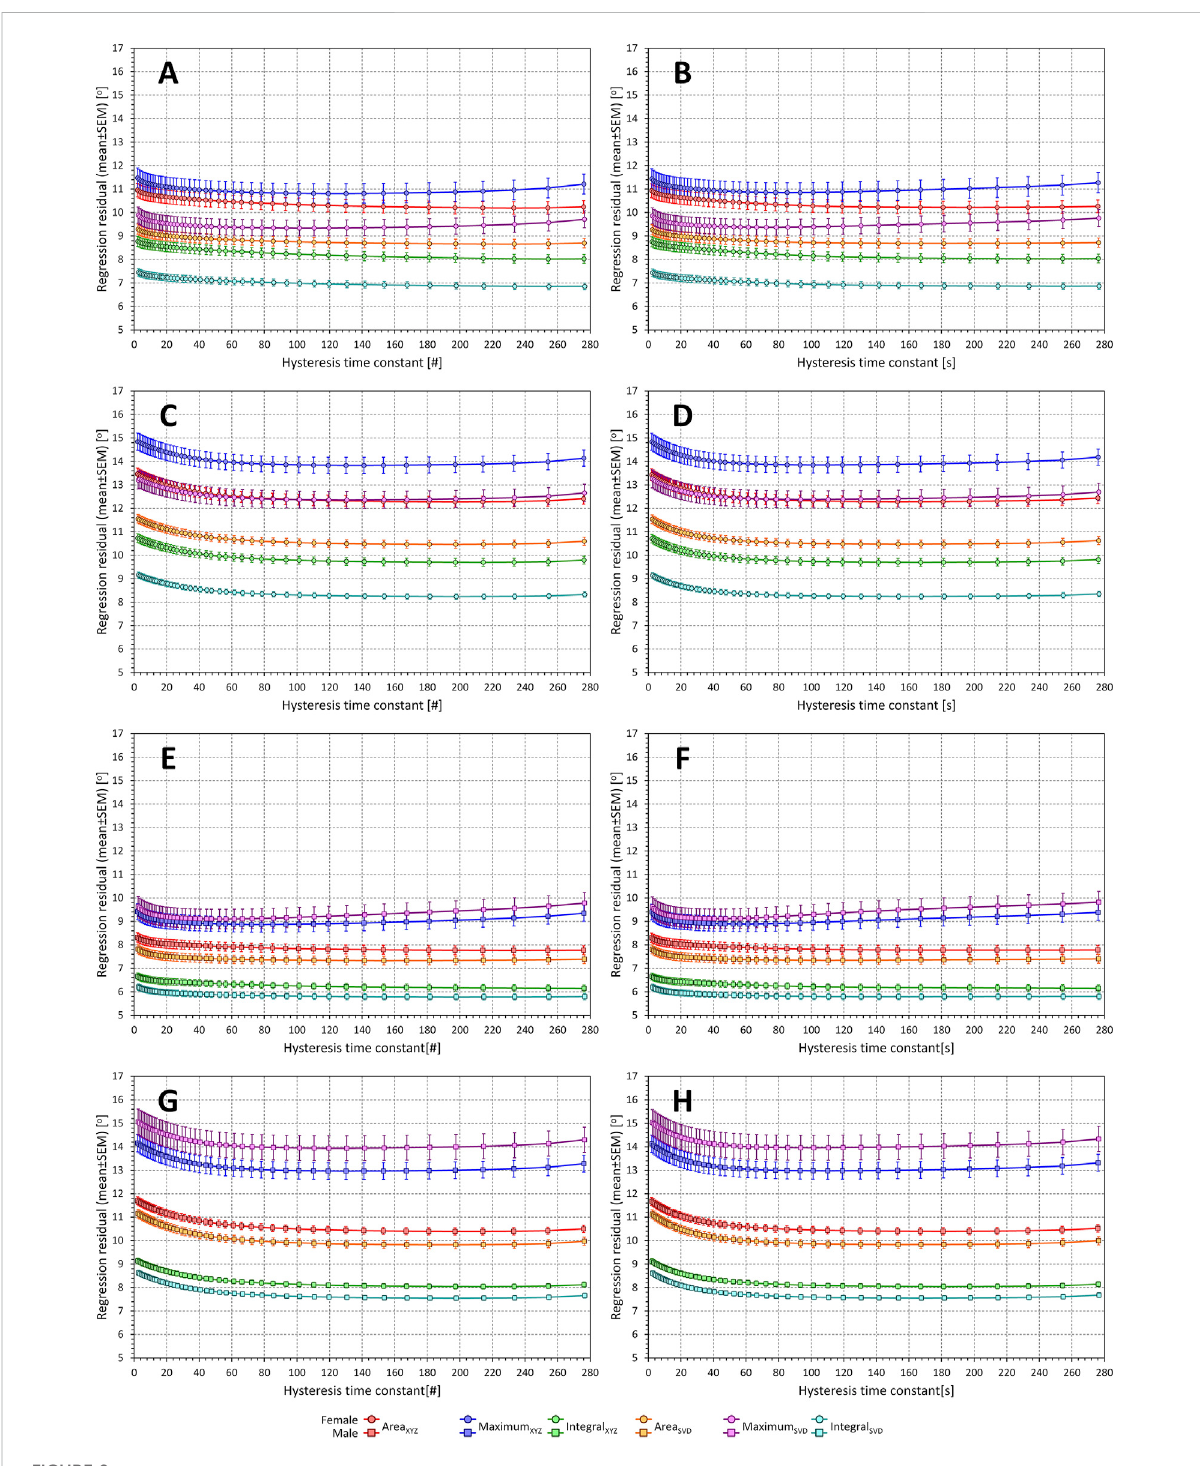
FIGURE 9 Regression residuals of QRS-T angle related to exponential decay of preceding heart rate. In each panel, the individual graphs correspond to different QRS-T angle expressions and show the mean ± standard deviation of intra-subject residuals of second-degree polynomial regressions betweenQRS-Tanglemeasurementsandheartratesderivedbyexponentialdecayhysteresismodelswithhysteresisconstantsofagivennumberof RR intervals [(#) — panels on the left] or a given number of seconds [(s) — panels on the right]. Panels (A,B) show the results in females with regressions involving only measurements preceded by variable heart rates; panels (C,D) show the results in females with regressions involving all measurements; panels (E) and (F) show the results in males with regressions involving only measurements preceded by variable heart rates; panels (G) and (H) show the results in males with regressions involving all measurements. Results related to the QRS-T angle expressions Area XYZ , Maximum XYZ , Integral XYZ , Area SVD , Maximum SVD , and Integral SVD are shown in red, blue, green, amber, violet, and cyan, respectively. See the text for the de fi nitions of the angle